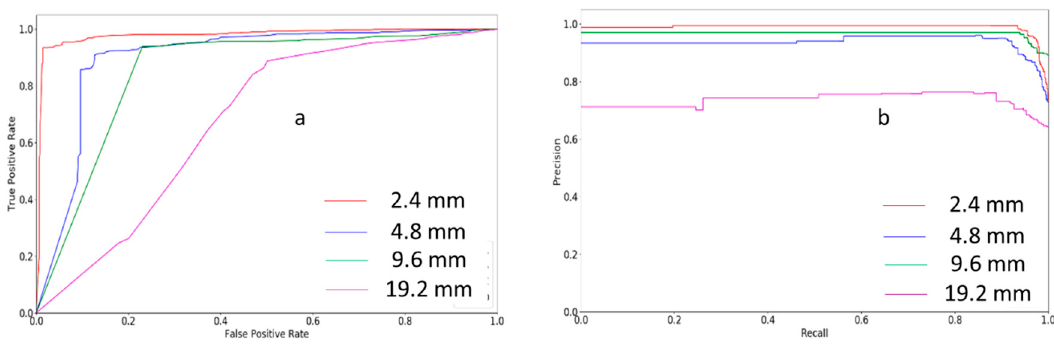
Figure 6. ROC curves ( a ), and PR plots ( b ) of downscaled testing data set in testing resolutions. The classifier accuracy was consistently penalized when the spatial resolution was degraded.